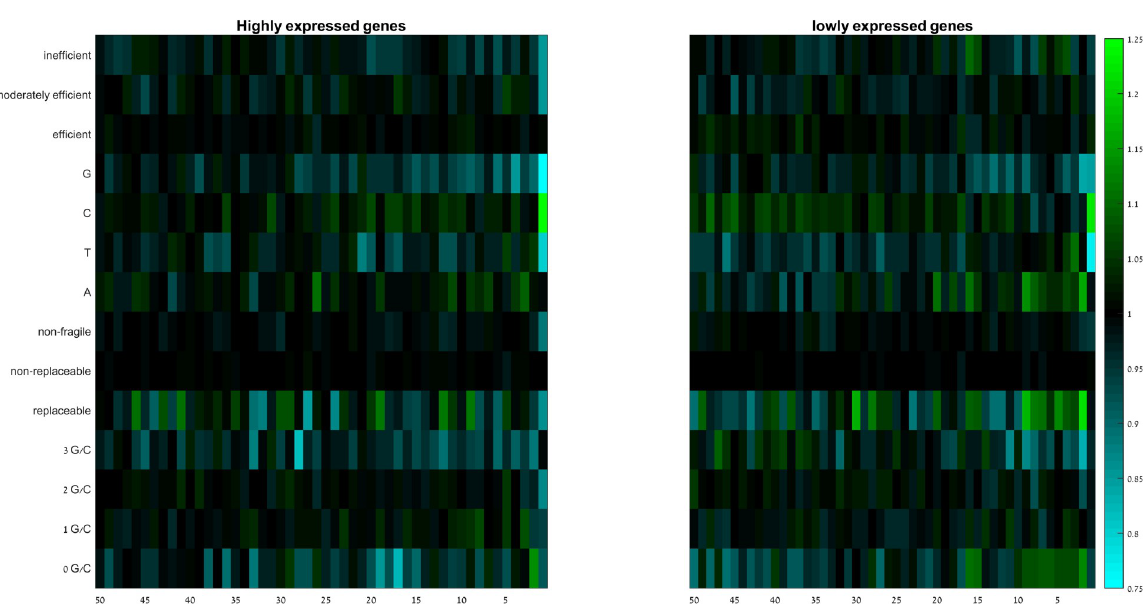
Fig 8. Group RSCA scores of all codons groups along the last 50 codons of human highly expressed and lowly expressed genes. Rows denote codons groups, columns denote positions. Species within domains are sorted from high (top) to low (bottom)